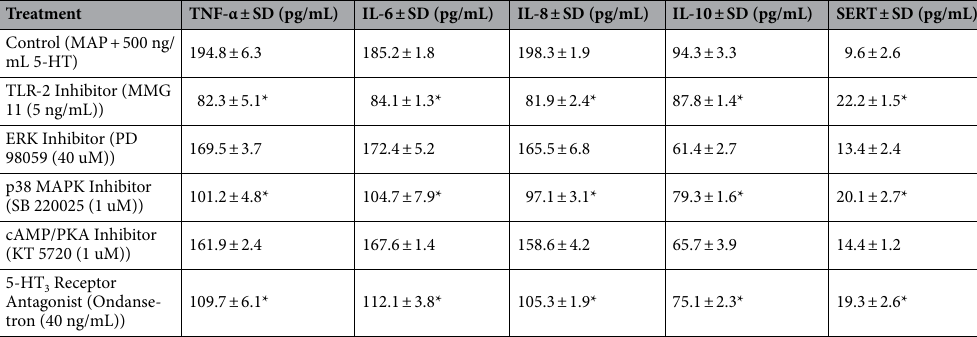
Table 2. Effects of several inhibitors involved in TLR-2 signaling pathway on protein level of TNF-α, IL-6, IL-8, IL-10 and SERT in MAP-infected Caco-2 monolayers in the presence of excess level (500 ng/mL) of 5-HT following 24 h of incubation. Values were pre-tested for normal distribution using the Kolmogorov–Smirnov normality test. Significance among experiments was assessed by two-way analysis of variance (ANOVA) followed by Bonferroni correction test. All ELISA experiments were performed in triplicates. * P value < 0.05.